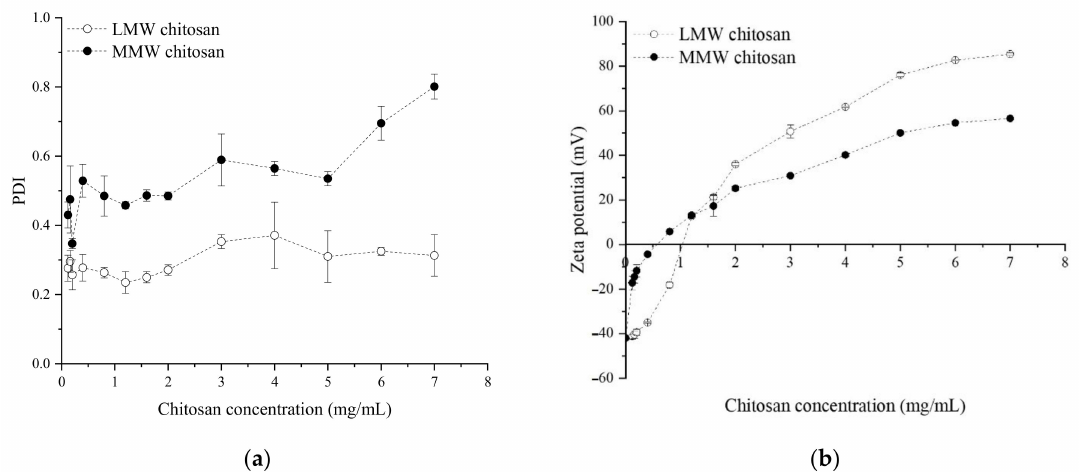
Figure 1. Effect of increasing concentrations of low and medium molecular weight chitosan on the ( a ) polydispersity index (PDI) and ( b ) zeta potential (ZP) of NE